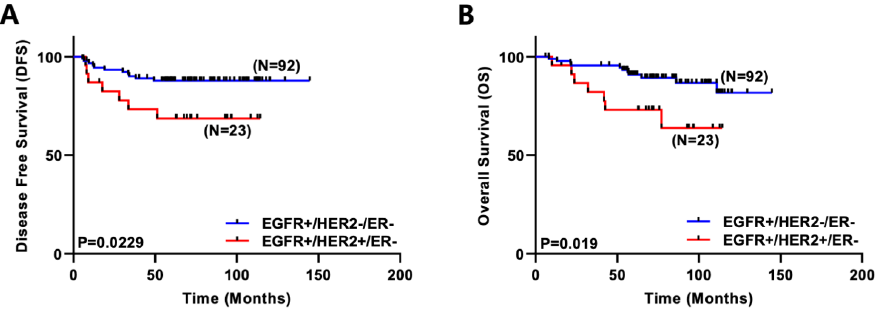
Figure 1. Co-expression of EGFR and HER2 correlates with poor survival in breast cancer patients. ( A ) Disease-free survival rates were compared between EGFR+/HER2-/ER- ( n = 92) and EGFR+/HER2+/ER- ( n = 23) patients ( p = 0.0229). ( B ) Overall survival rates were compared between EGFR+/HER2-/ER- ( n = 92) and EGFR+/HER2+/ER- ( n = 23) patients ( p = 0.019).